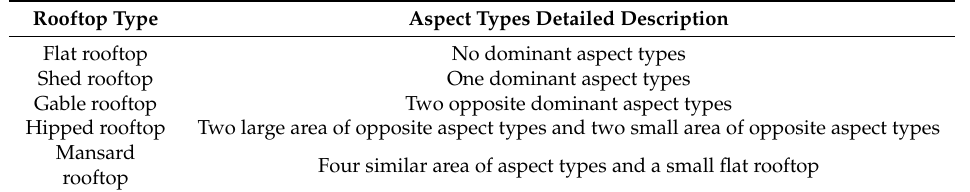
Table 2. Different rooftop type recognition criterion based on aspect.